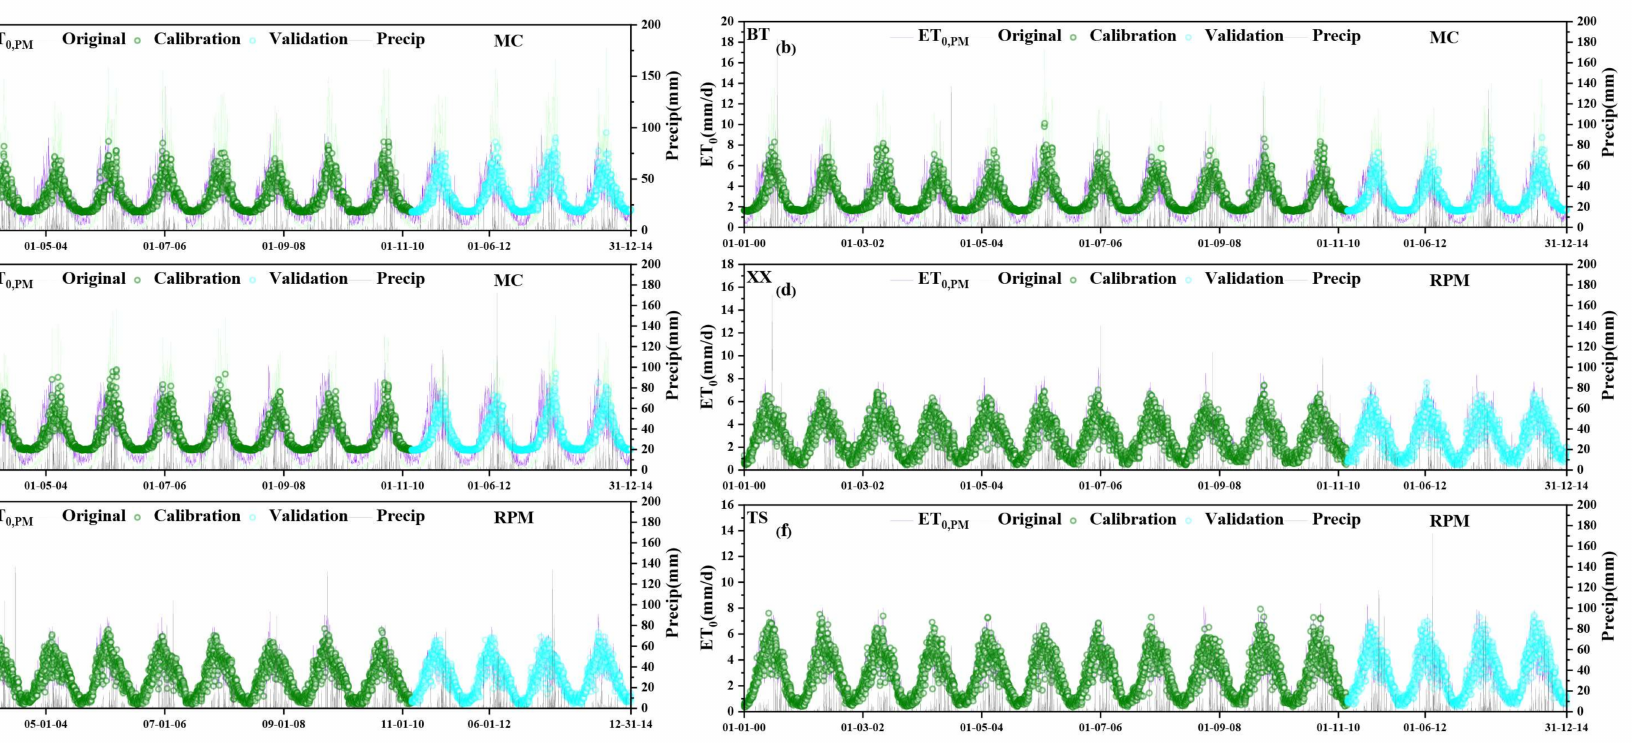
Figure 5. Variation in ET 0 estimated by the MC and RPM temperature-based models and PM and Precipitation (Precip) for stations BT, TS, and XX; ( a – c ) MC model and the ( d – f ) RPM